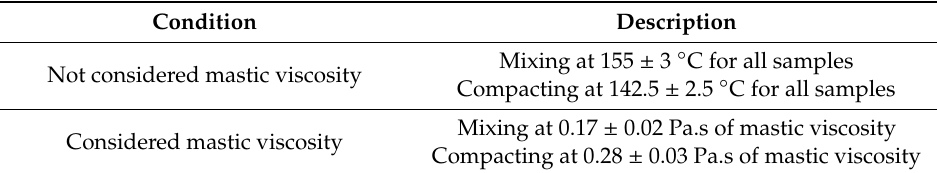
Table 3. Conditions of asphalt concrete mixture